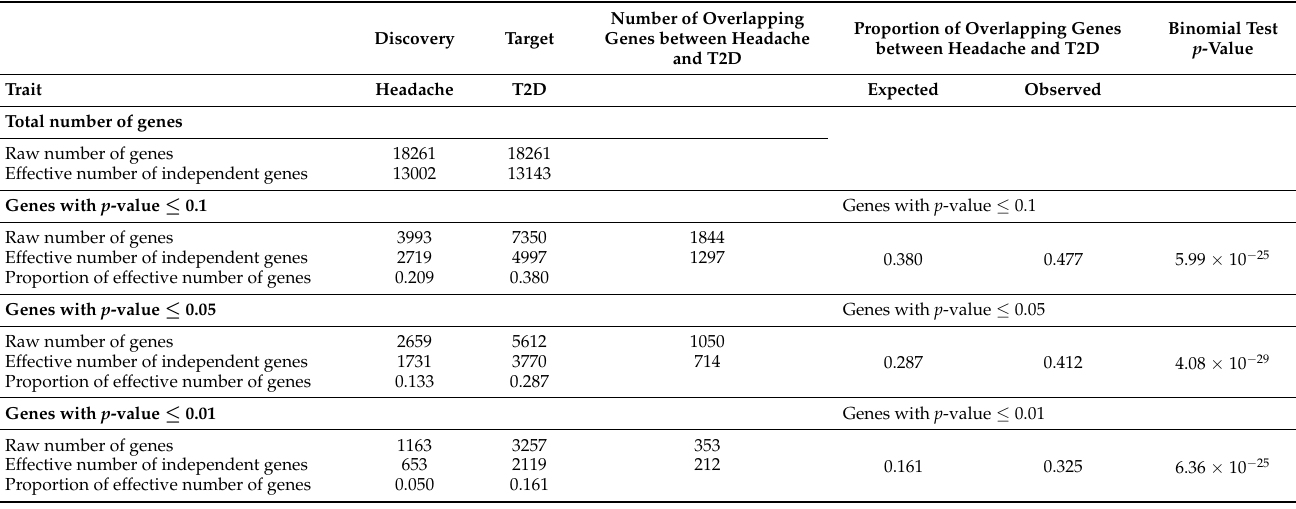
Table 6. Results for independent gene-based and gene-level genetic overlap analysis between headache and